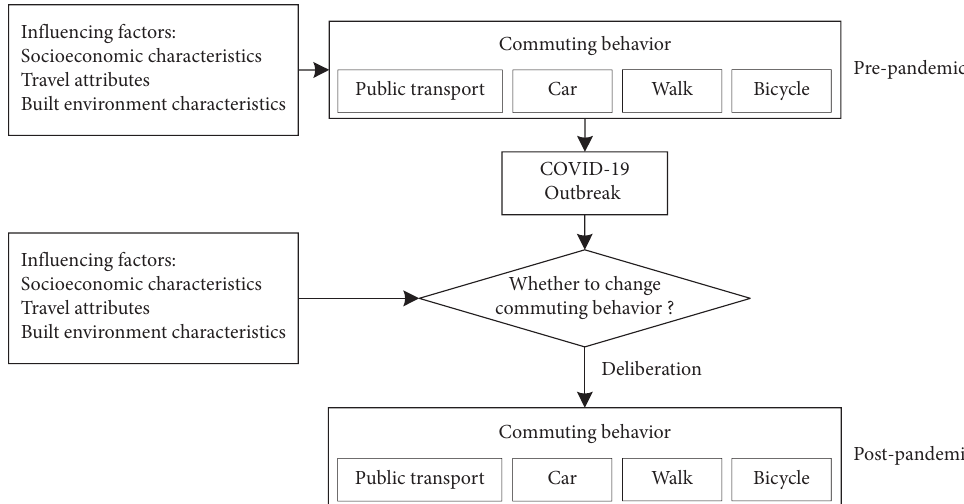
Figure 1: Conceptual model of the relationship between variables and commuting behavior